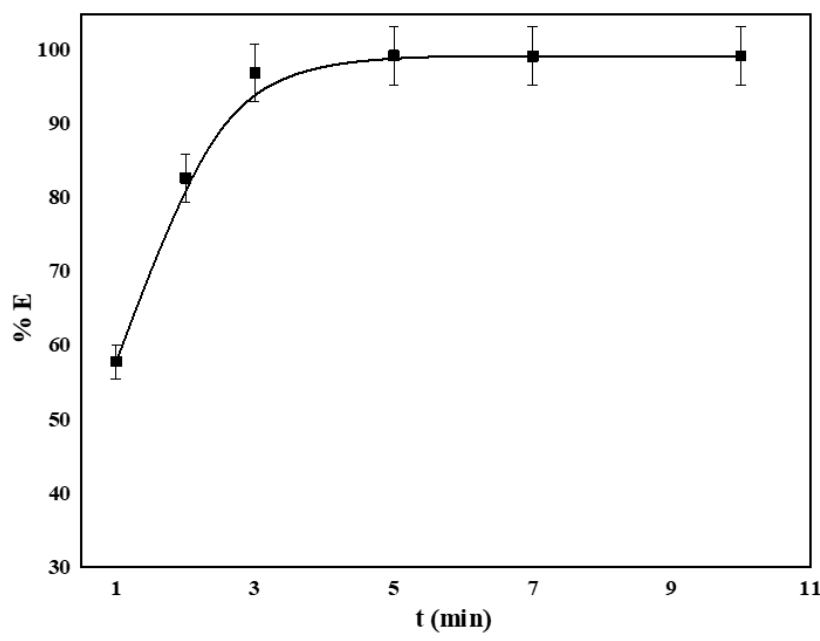
Figure 5. Effect of phase ratio on MB extraction efficiency. [MB] = 200 mg dm − 3 ; T = 25.0 °C.